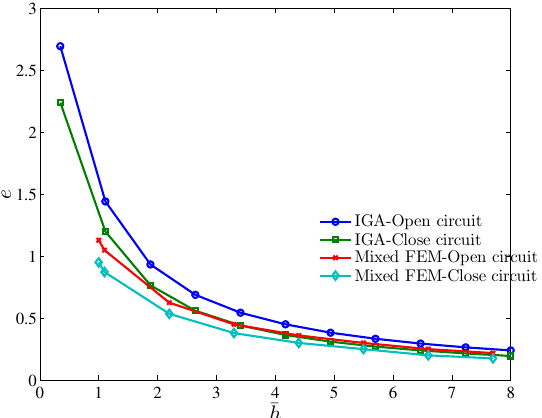
Figure 8. Effective piezoelectric constant under different electrical boundary